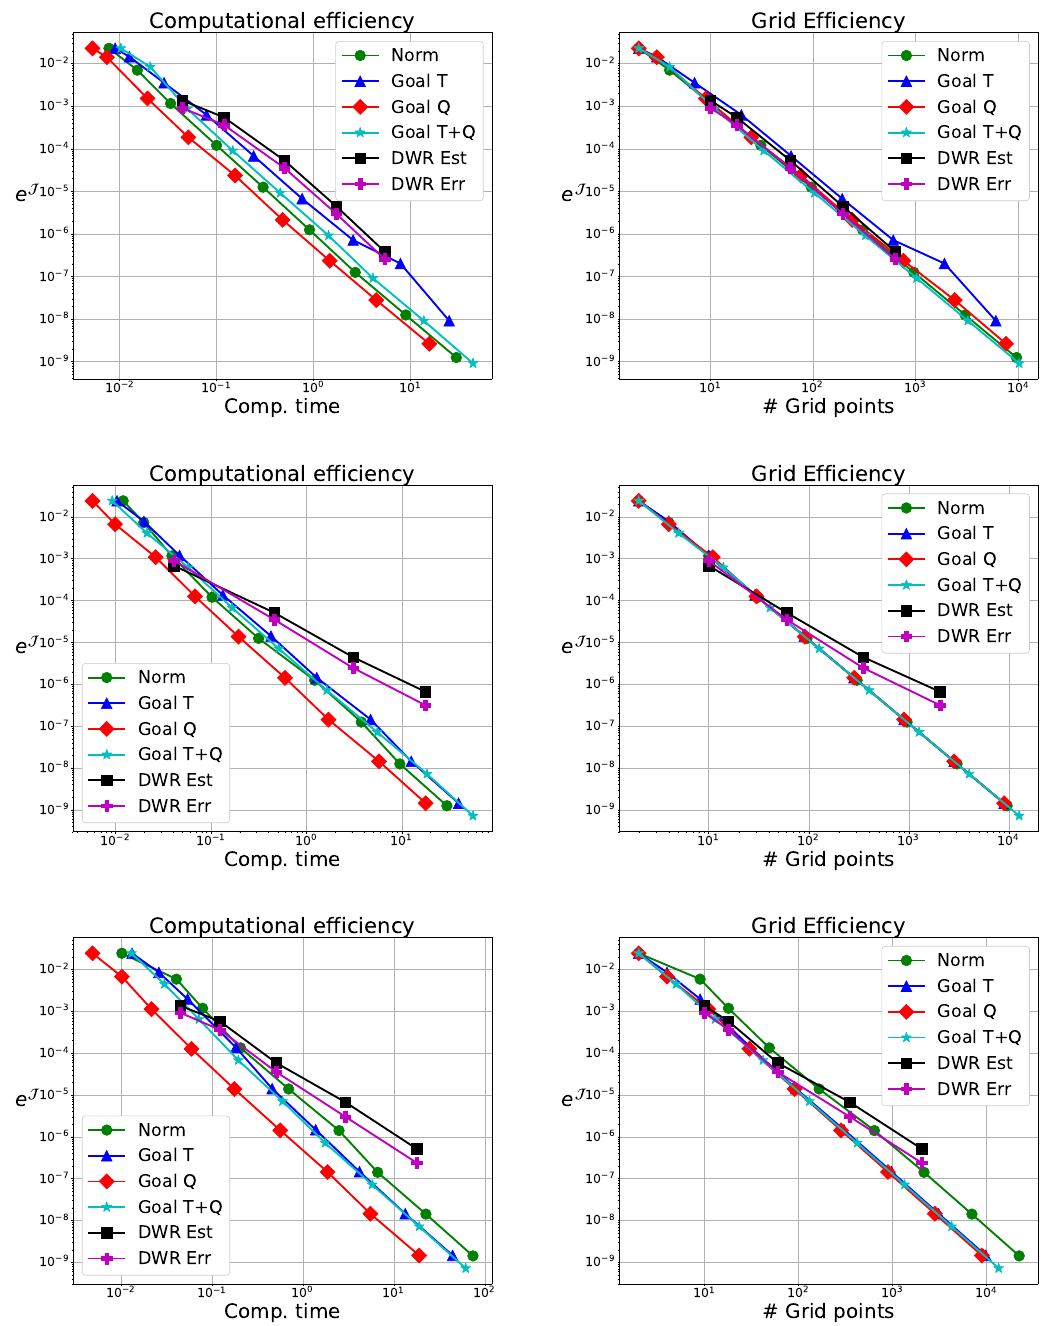
Figure 2. Performance comparison of the various methods for Problem (33). Top : k = − 1 and j ( t , u ) = u 1 , center : k = − 1 and j ( t , u ) = u 2 , bottom : k = − 100 and j ( t , u ) = u 1